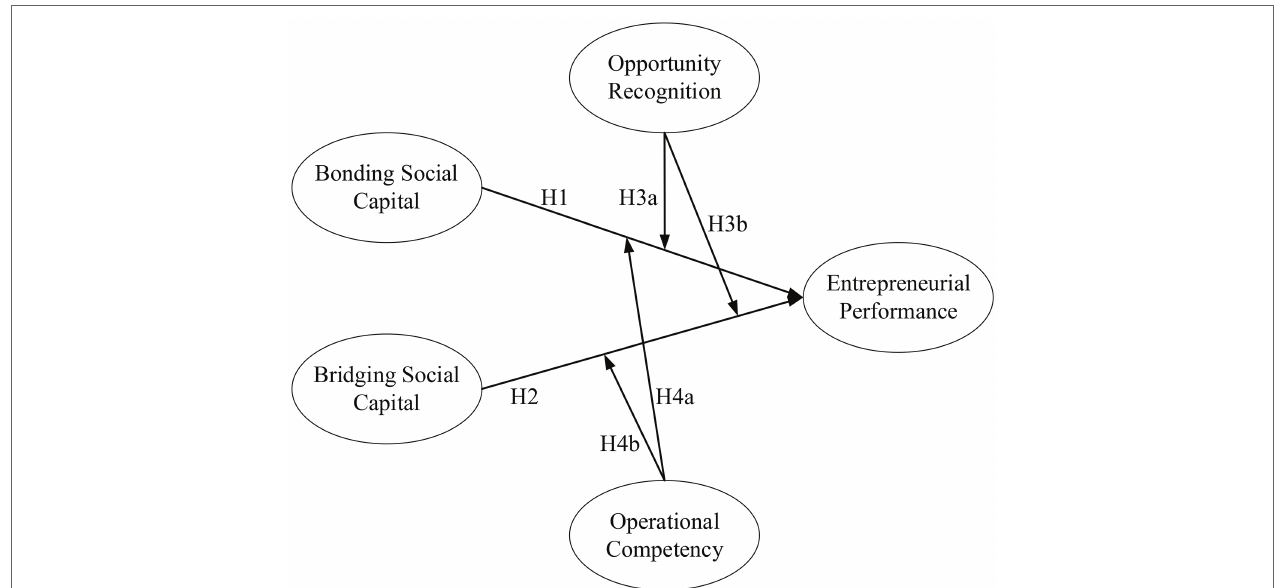
FIGURE 1 | Research